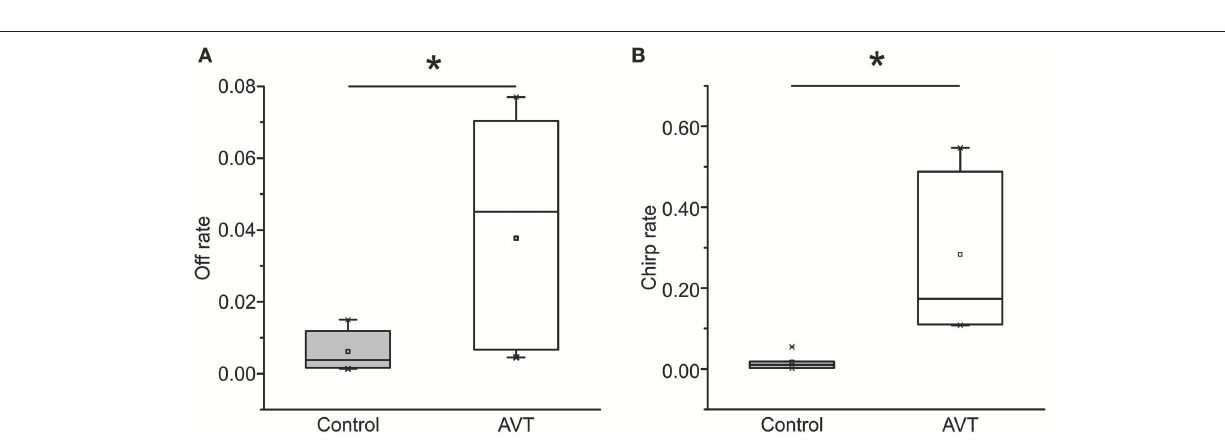
FIGURE 3 | AVT effects on the rate of emission of transient electric submission signals. (A) Offs. AVT administered to subordinates increases off rate. Control vs. AVT, Mann–Whitney U -test, p = 0.03, ncontrol = 7, nAVT = 7. (B) Chirps. AVT administered to subordinates increases chirp rate. Control vs. AVT, Mann–Whitney U -test, p = 0.04. ncontrol = 7, nAVT = 6. * p <